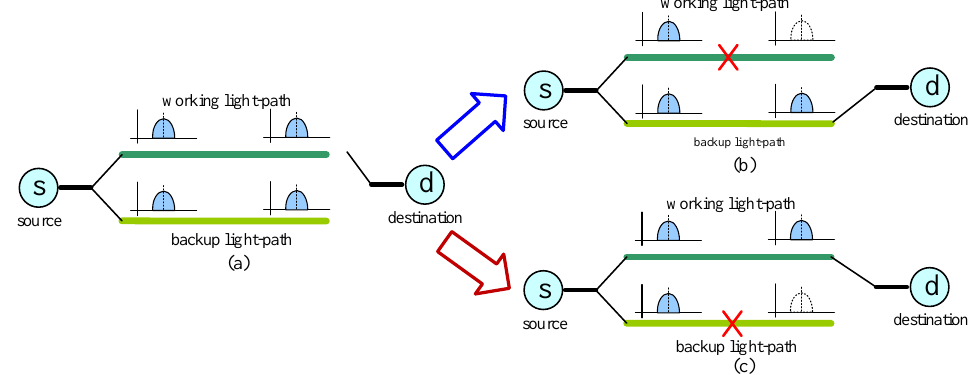
Figure 3. The 1 + 1 protection scheme: ( a ) 1 + 1 protection configuration; ( b ) the failure occurs at the working light path; ( c ) the failure occurs at the backup light path; s: source node and d: destination node.